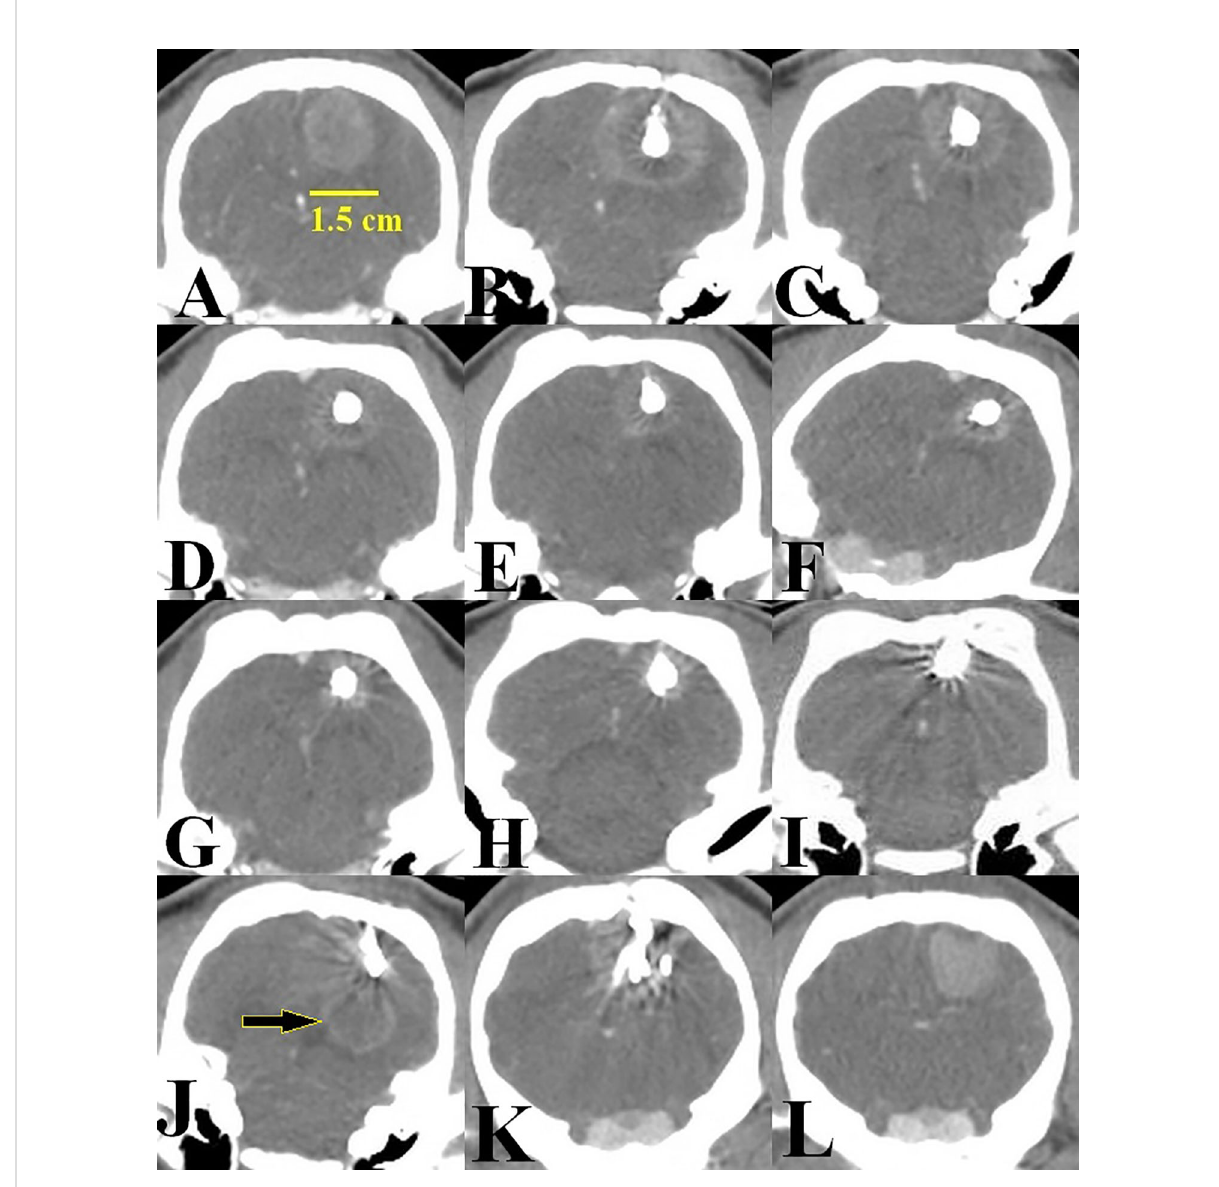
FIGURE 4 Representative example of the images acquired fromD14 onwards. (A) D14, tumorsize1.5 cmjust before Ho injection, (B) D14,presenceof 166Ho just after intratumoral injection, group 1, (C) 5 daysafter intratumoral injection of166Ho. Tumor size is regressing, (D) 15daysafter intratumoral injection of 166 Ho. Tumor sizeis regressing, (E) 25 dayspost-injection of 166 Ho, (F, G) 45 and 55 days post-injectionof 166 Ho. A small volume oftumor is observable, (H) 65 days post-injection of 166 Ho, just before animal euthanasia at the end ofthe observation period(D80), (I) Tumor condition